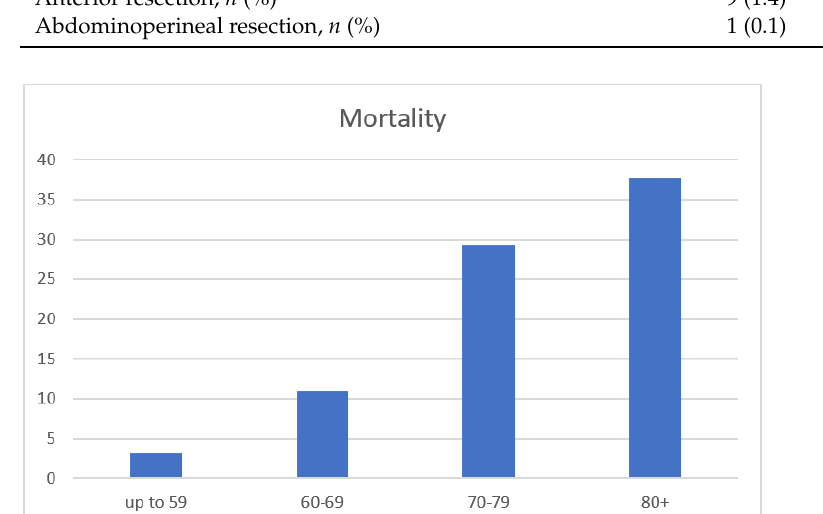
Figure 3. 30-day mortality rates in each age group.